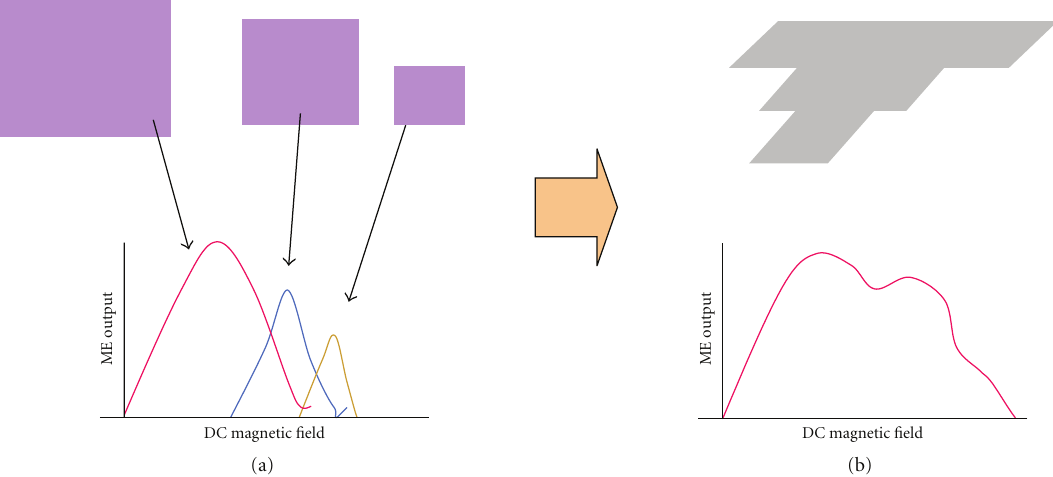
Figure 6: Schematic diagram of modified sensor structure. Based on the results of ME dependency on the size (a), dimensionally gradient structure was designed as shown in (b).